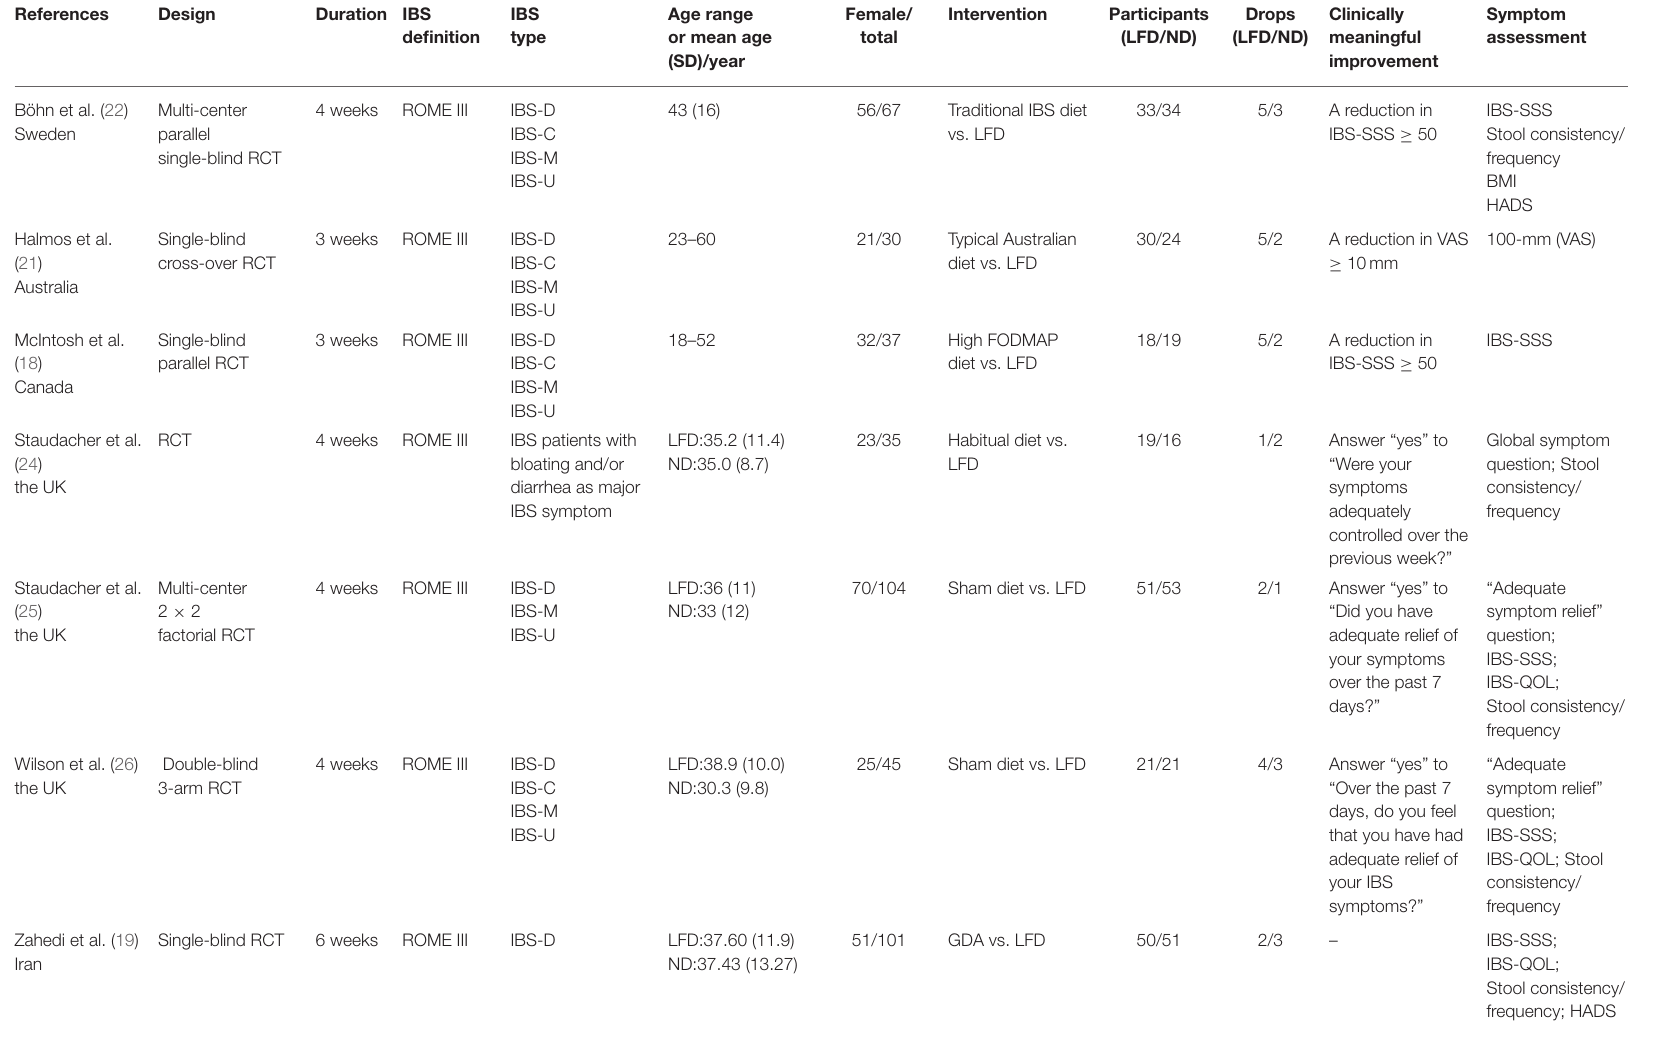
TABLE 1 | Baseline characteristics of the studies included in the